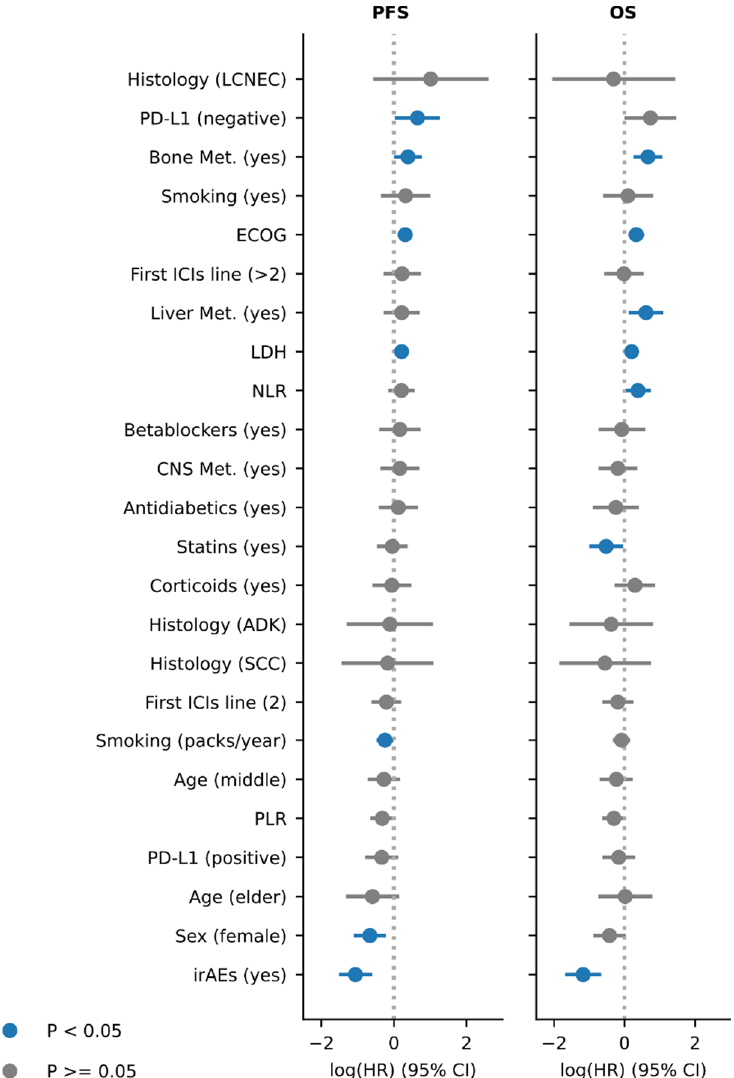
Figure 1. Clinicopathological features associated with ICIs response in multivariate survival models. ( Left ) Multivariate Cox proportional-hazards survival model using the PFS as measure of ICIs benefit. ( Right ) Multivariate Cox proportional-hazards survival model using the OS as measure of ICIs benefit. Features in blue are statistically significant ( p < 0.05).